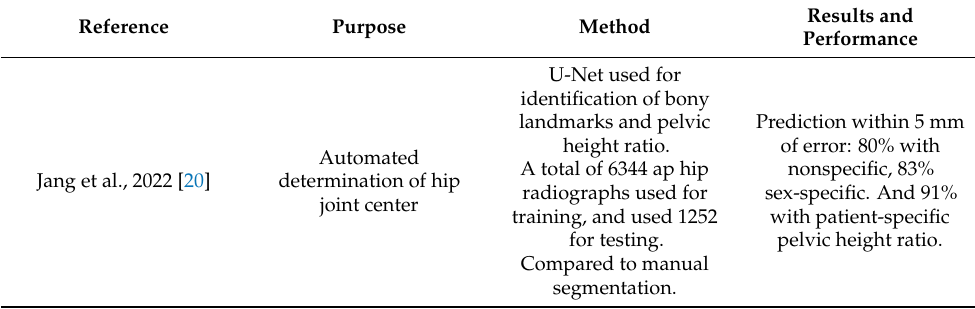
Table 1. Selection of studies on artificial intelligence and measurements of the hip. ap = anterior- posterior CE = center-edge angle of Wiberg, FHEI = femoral head extrusion index, PCK = percentage of correct key points, ICC = intraclass correlation index, r = Pearson’s coefficient, RMSE = root